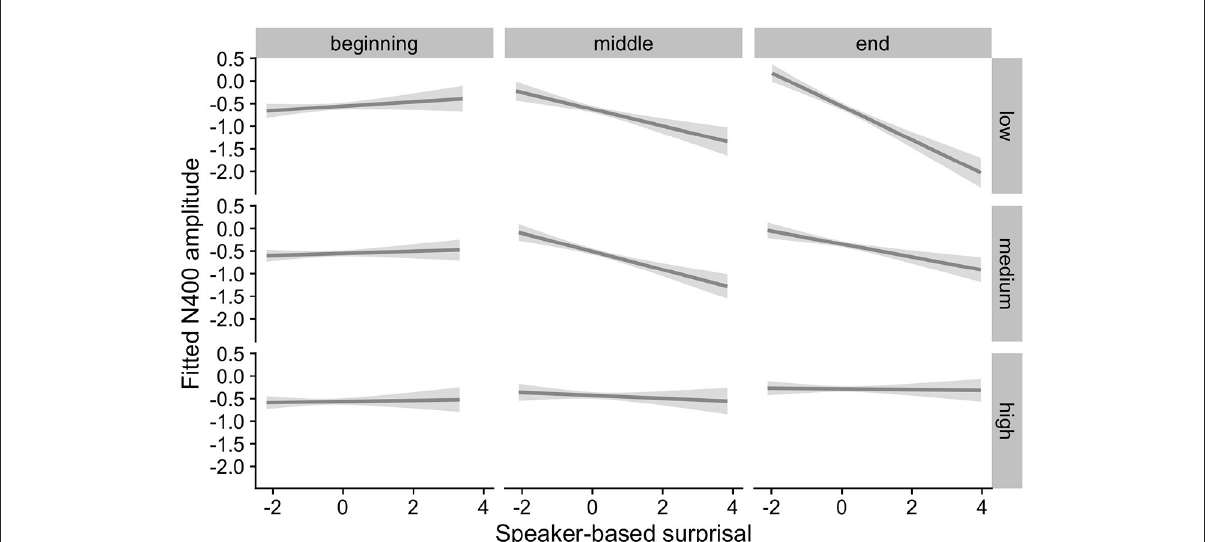
FIGURE11 Effects of IAF on changes in the relationship between speaker-based surprisal (z-transformed) and N400 amplitude over the course of the experiment in the combined analysis of Experiments 1 and 2 ( n = 85). The figure visualizes partial effects as calculated using the remef package, adjusted for Prestimulus Amplitude and Frequency. Note that position in the experiment (operationalised via epoch in the statistical model) is trichotomised into beginning, middle and end for visualization purposes only; epoch was included in the model as a continuous predictor. The same holds for the individual differences variables, which are trichotomised for visualization purposes but were entered into the statistical models as a continuous predictors. Shaded areas indicate 95% confidence intervals.